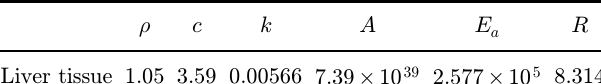
Table 2. Thermal and physiological properties of porcine liver. 9